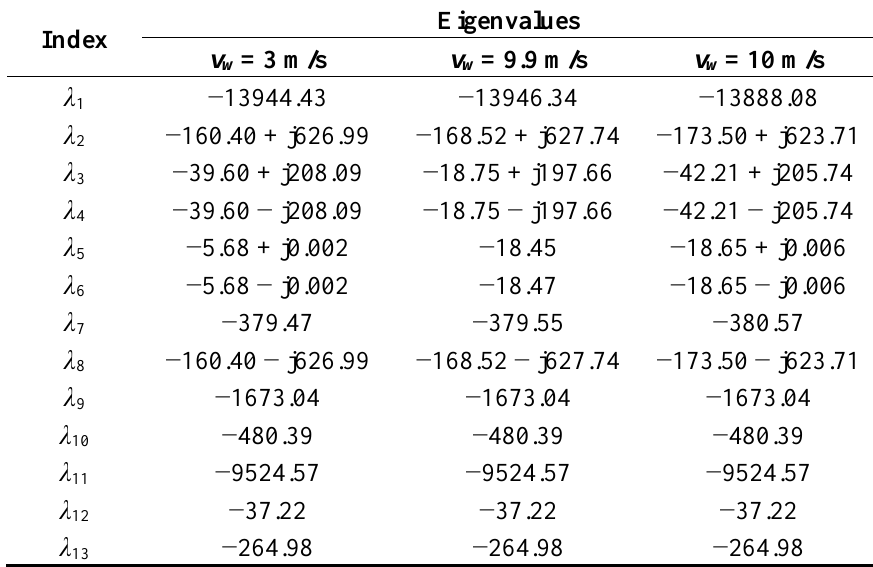
Figure 8. The parameters obtained by using PSO algorithm for various wind speeds. ( a ) K p2 and K i2 for v w = 3–11 m/s. ( b ) K p4 and K i4 for v w = 3–11 m/s. Table 4. Eigenvalues for the proposed method at particular wind